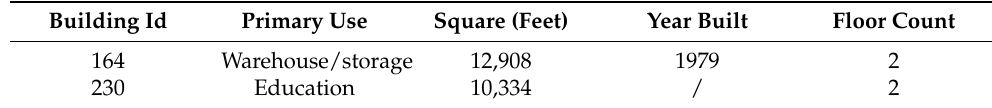
Table 7. The basic information of Building 164 and Building